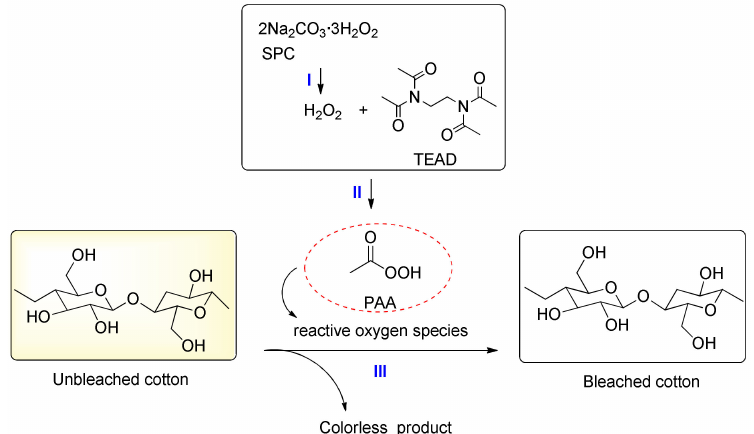
Figure 1. Bleaching mechanism of a TAED/SPC-activated system for the cotton